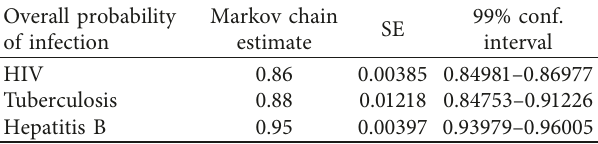
Table 8: Estimated bootstrap confidence intervals. Overall probability